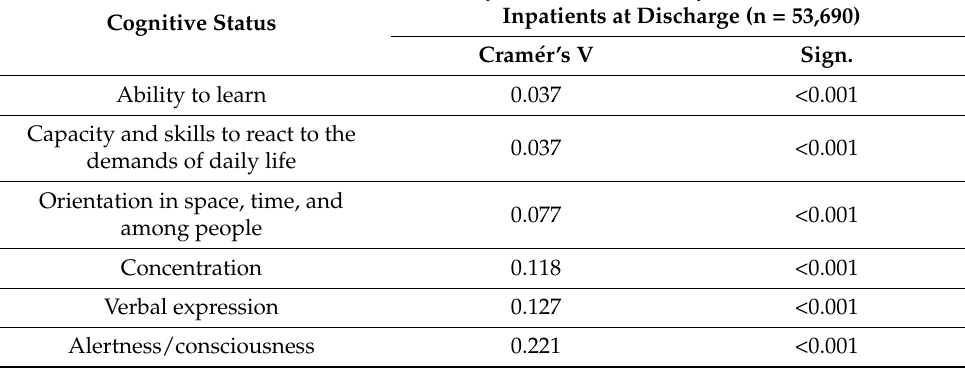
Table 5. Associations between PP and cognitive status among geriatric inpatients at discharge (n = 53,690).